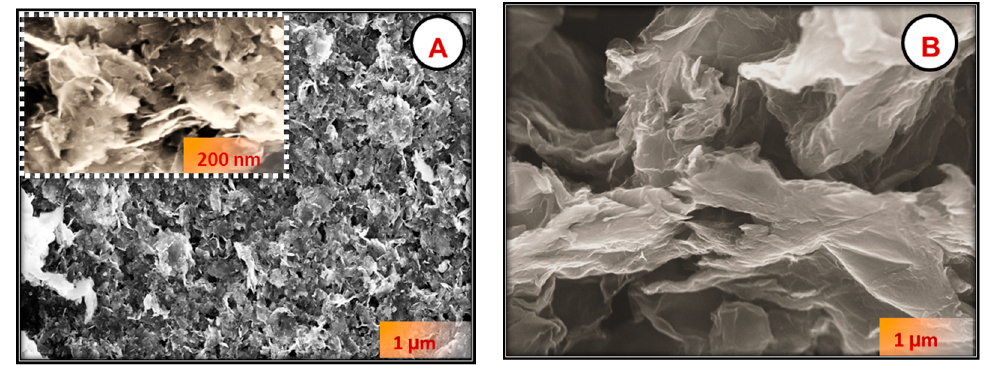
Figure 5. Scanning electron microscope micrographs of: ( A ) dispersed graphene nanoplatelets (inset represents higher magnification (bar = 200 nm)); and ( B ) reduced graphene oxide nanosheets.